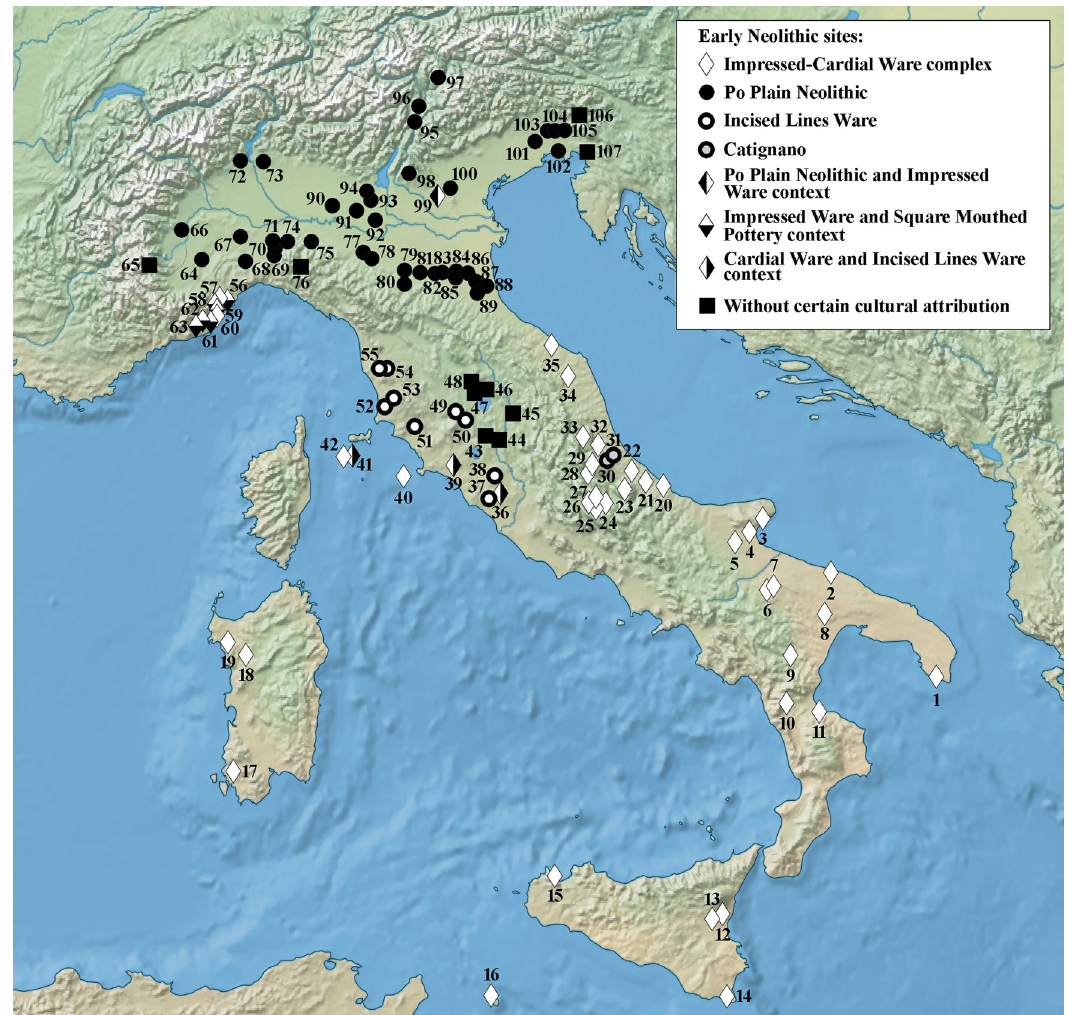
Figure 2: Early Neolithic sites with personal ornaments: ( 1 ) Torre Sabea; ( 2 ) Scamuso; ( 3 ) Coppa Nevigata; ( 4 ) Passo di Corvo;